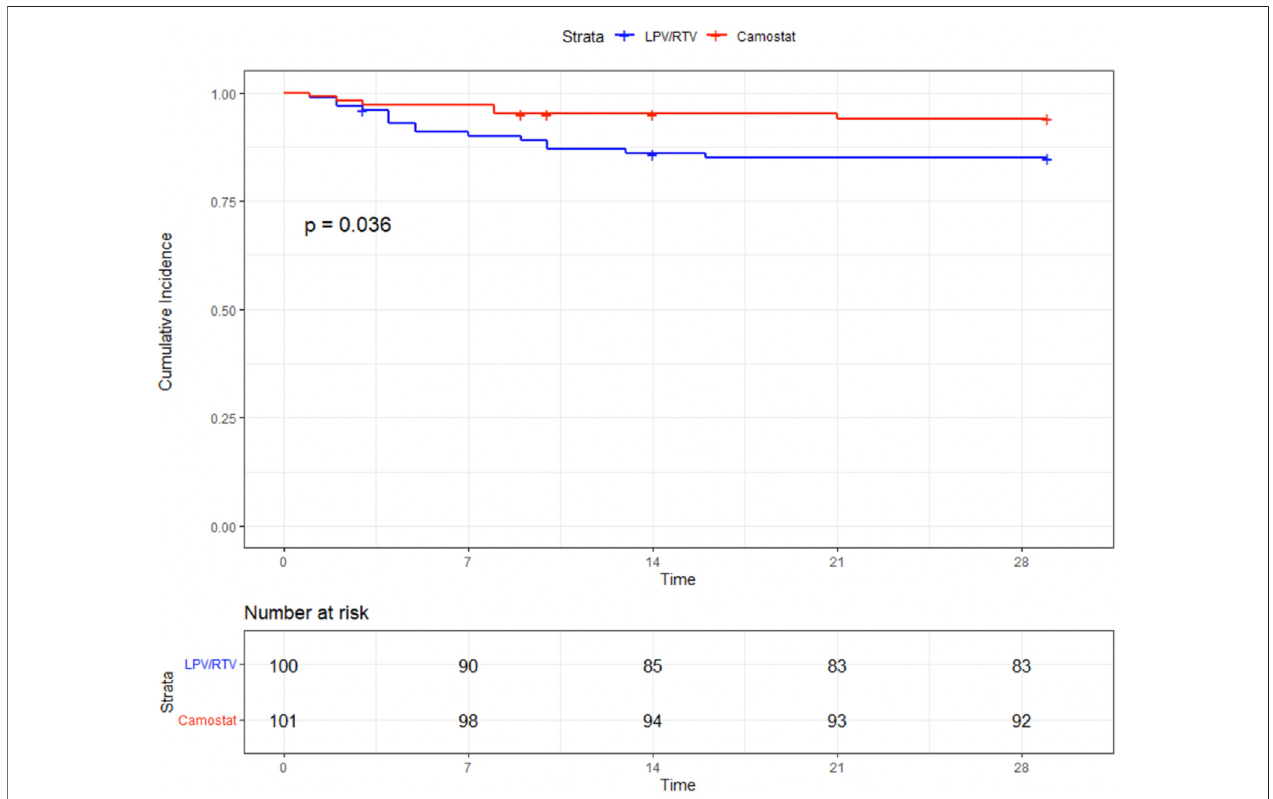
FIGURE 3 | Time (in days) to mechanical ventilation or